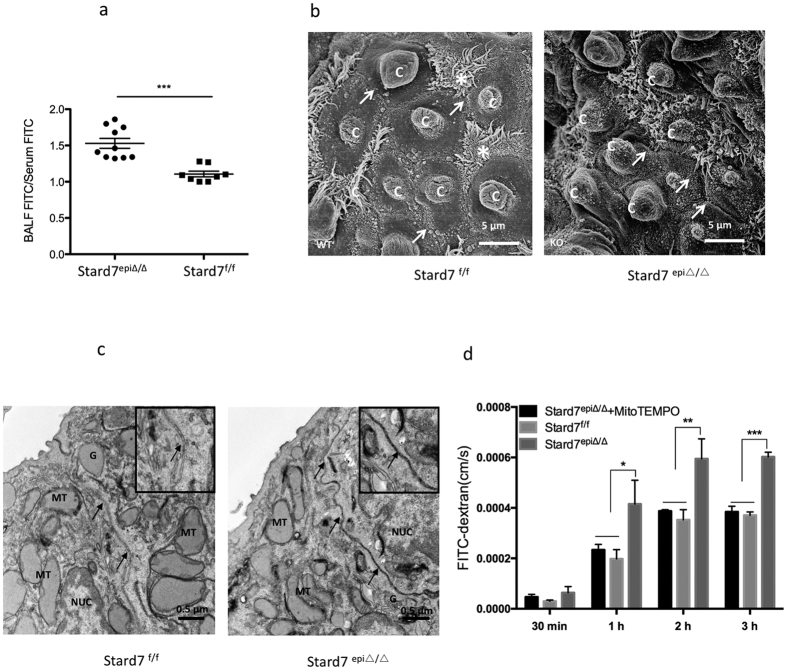
Altered epithelial barrier structure and function in Stard7epi∆/∆ mice.(a) Epithelial barrier permeability was assessed by tail vein injection of FITC-albumin, followed by quantitation of FITC in BALF and serum from Stard7f/f and Stard7epi∆/∆ mice. Results are expressed as BALF FITC/Serum FITC, n = 8–10 mice/group. Stard7f/f mice vs. Stard7epi∆/∆ mice, ***p = 0.0001. (b) SEM detected surface fractures between bronchiolar epithelial cells (asterisk) and club cells (C) in Stard7epi∆/∆ mice. (c) Fixed mouse lungs were cut into 1–2 mm lung slices, incubated with 2% lanthanum nitrate at room temperature overnight, and processed for electron microscopy. Penetration of electron dense lanthanum nitrate into the intercellular spaces (arrow) was detected in the airway epithelium of Stard7epi∆/∆ mice. G: Golgi, MT: mitochondria, NUC: Nucleus. (d) Tracheal epithelial cells were isolated from Stard7epi∆/∆ and Stard7f/f mice and cultured until TEER >220/cm2. Cells were subsequently differentiated at an air-liquid interface for 3 weeks and treated with/without MitoTEMPO (5 μM) every other day. Paracellular flux of FITC-dextran was measured over a 3 hr period. Stard7epi/∆∆ vs. Stard7epi∆/∆ + MitoTEMPO, *p = 0.0311, **p = 0.0106, ***p < 0.001; Stard7epi∆/∆ vs. Stard7f/f, *p = 0.0201, **p = 0.0091, ***p < 0.001.